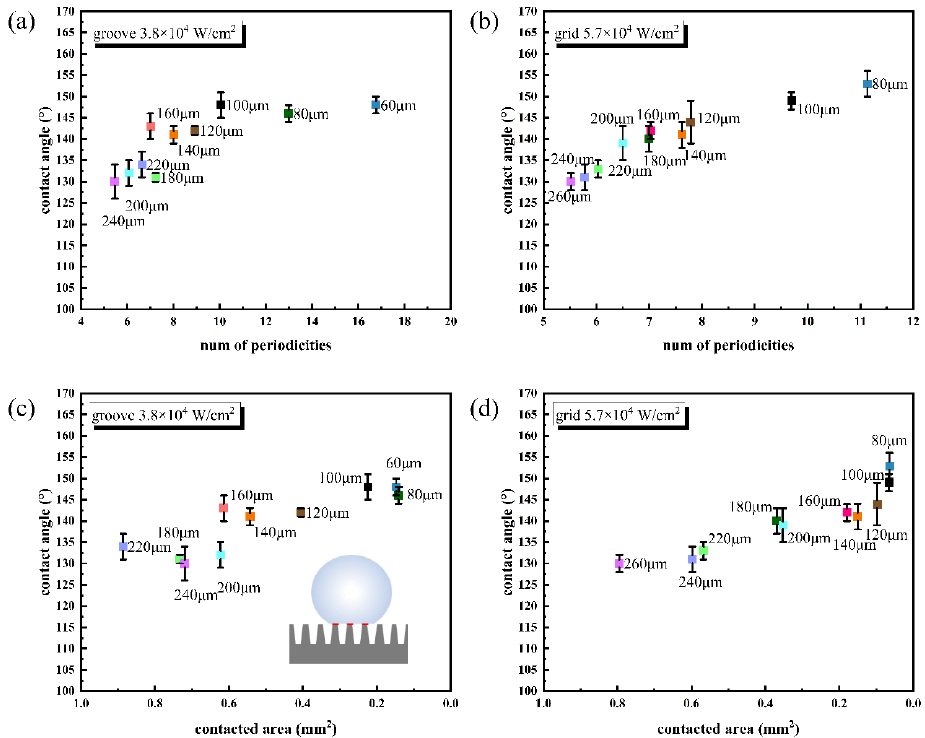
Figure 5. The relationship between number of periodicities and CA on ( a ) groove processed by 3.8 × 10 4 W/cm 2 , and ( b ) grid processed by 5.7 × 10 4 W/cm 2 . The relationship of contacted area and CA on ( c ) groove processed by 3.8 × 10 4 W/cm 2 , and ( d ) grid processed by 5.7 × 10 4 W/cm 2 .